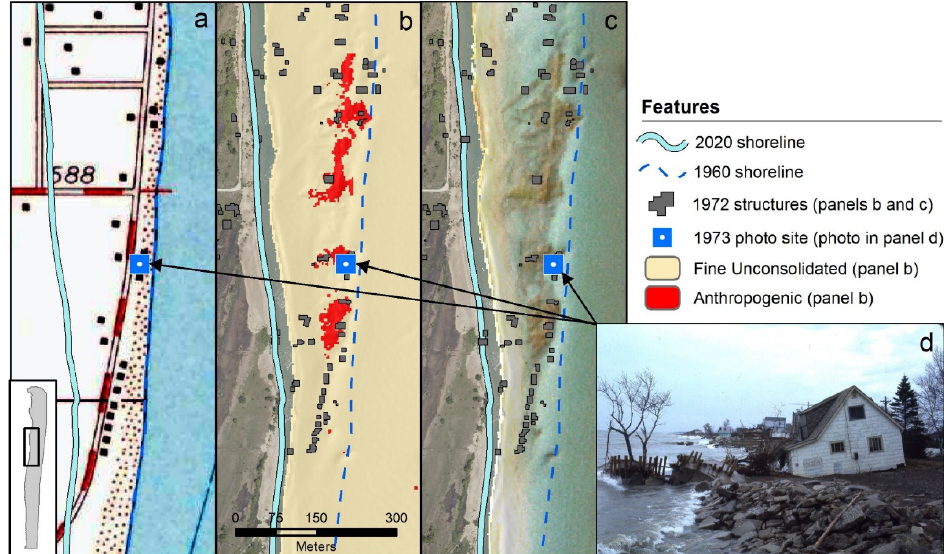
Figure 24. Shoreline changes and destruction of infrastructure illustrated in the central part of the study area as a result of lake level changes between 1960 and 2020: ( a ) 1960 topographic map obtained from the U.S. Geological Survey [57] showing homes and roads along the shoreline with the superimposed 2020 shoreline (digitized from RGB aerial imagery collected by the JALBTCX in 2020), ( b ) Tier 1 substrate classification result using airborne data inputs from 17 July 2018, highlighting remnants of various infrastructure found offshore (1973 structures digitized from historic topographic maps, [58]) and classified as anthropogenic substrate (in red), ( c ) airborne fusion image from 17 July 2018 also illustrating offshore benthic environment, and ( d ) 1973 photograph showing destruction of a home impacted by the shoreline erosion